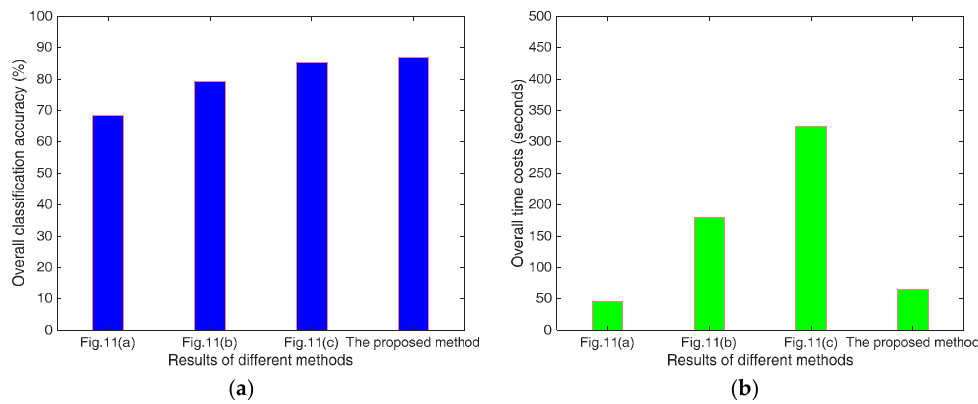
Figure 12. Overall classification accuracy ( a ) and time costs ( b ) of three experiments in Figure 11. Table 4. Accuracy of the individual classification results in Figure 11.